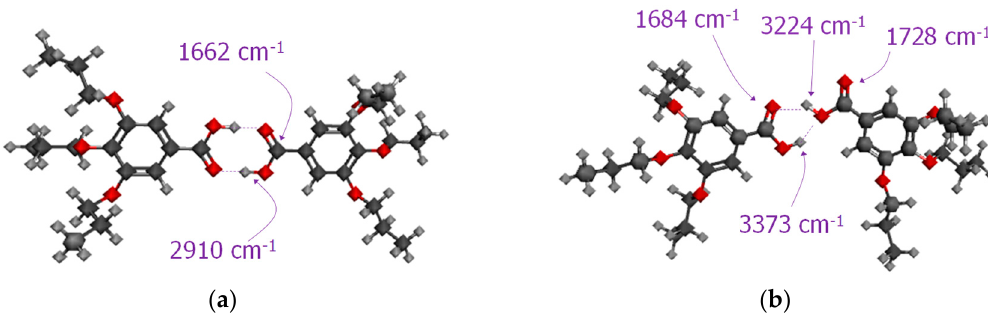
Figure 3. Models obtained by density functional theory (DFT) calculations corresponding to: ( a ) symmetric dAZOi dimers, dAZOi-2HB-sym, and ( b ) asymmetric dAZOi dimers, dAZOi-2HB-as, including the vibration frequencies calculated by DFT (see Table S1 in Supplementary Materials for associations with Figure 2). Dotted lines indicate hydrogen bonding.